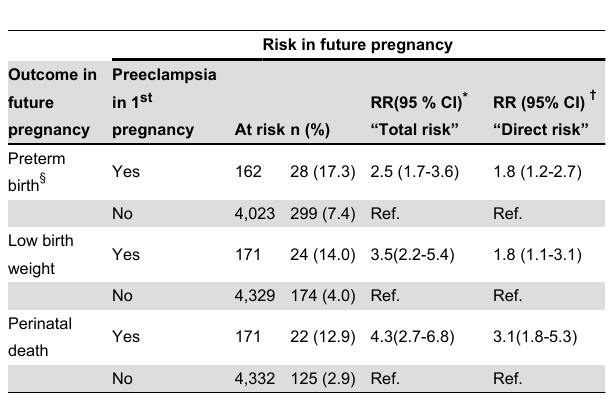
Table 3. Preeclampsia and risk of adverse fetal outcomes in a future